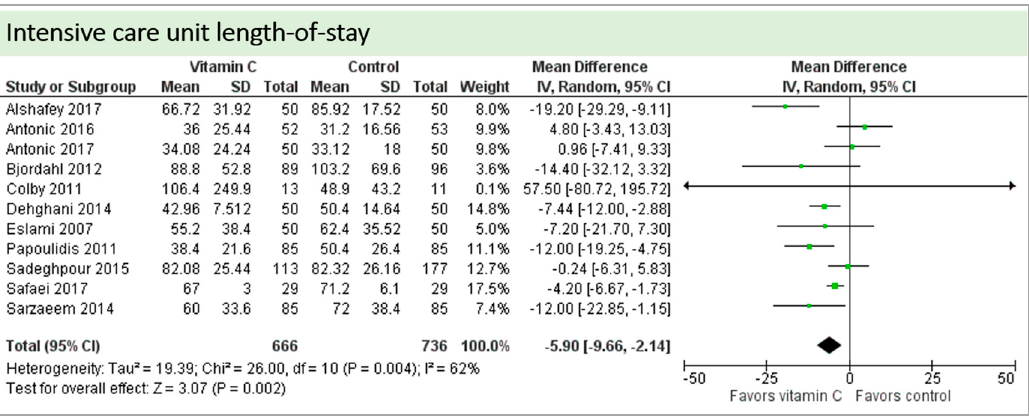
Figure 8. Intensive care unit (ICU) length of stay.